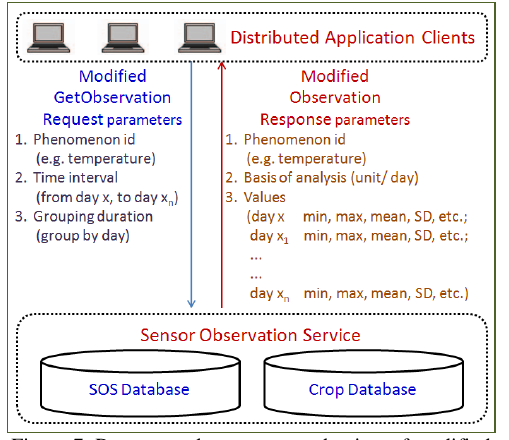
Figure 7. Request and response mechanism of modified GetObservation operation